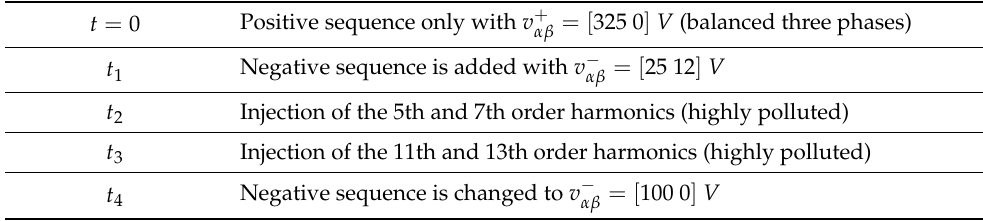
Table 4. The estimated frequency ω (cid:48) and the respective errors ( ω − ω (cid:48) ) are illustrated in Figures 10 and 11, respectively. In Figure 10, it can be noticed that all methods remain near the nominal frequency with the exception of the SRF-PLL. Its performance is significantly poor when facing unbalanced conditions and further deteriorates when high low-order harmonics are present in the three-phase voltage. For these reasons, the following analysis disregards the SRF-PLL and justifies the need for methods capable of extracting the FFPS. Table 4. Introduced voltage unbalancing and harmonics during test #1.